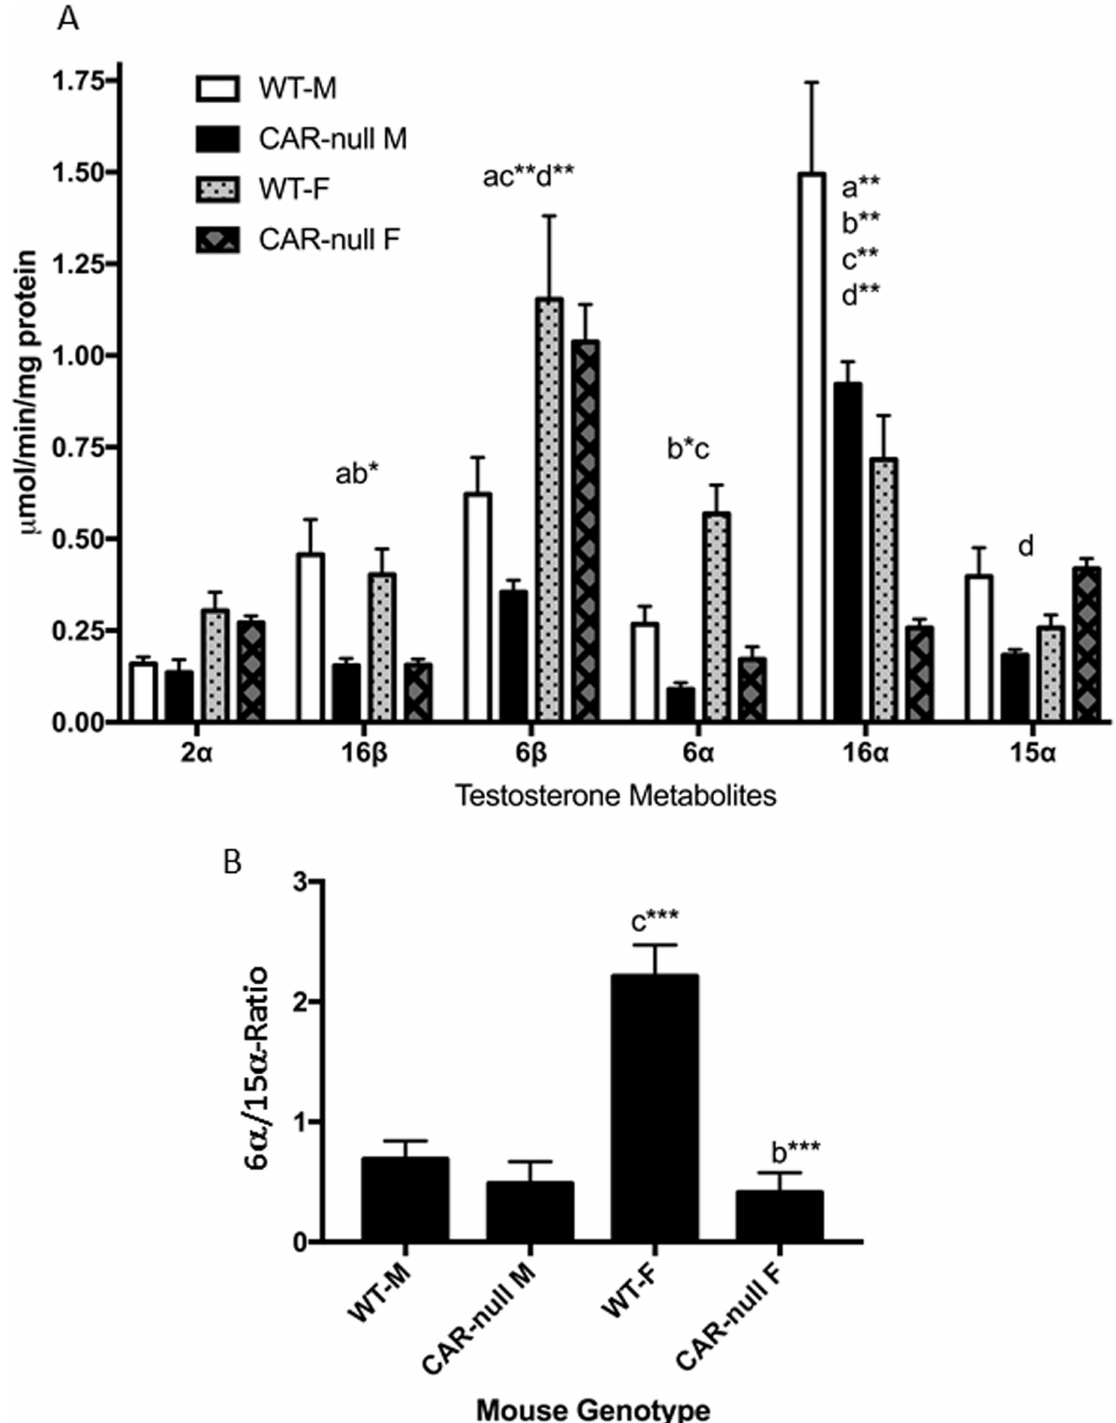
Fig 3. Testosterone hydroxylation is perturbed in CAR-null mice in a gender-specific manner. (A) Testosterone hydroxylation was determinedin male and female WT and CAR-nullmice as describedin the Materials and Methods. Data are presentedas mean specific activity ( μ mol/min/mgprotein) ± SEM (n = 5). (B) Ratio of 6 α /15 α -hydroxytestosterone as a biomarker of CYP sexual dimorphismin the liver. An a indicatesa significantdifference betweenWT male and Cyp2b9/10/13-null male mice, b indicatesa significantdifference betweenWT female and Cyp2b9/10/13-nullfemale mice, c indicatesa significant difference betweenmale and female WT mice and d indicatesa significantdifference betweenthe male and female Cyp2b9/10/